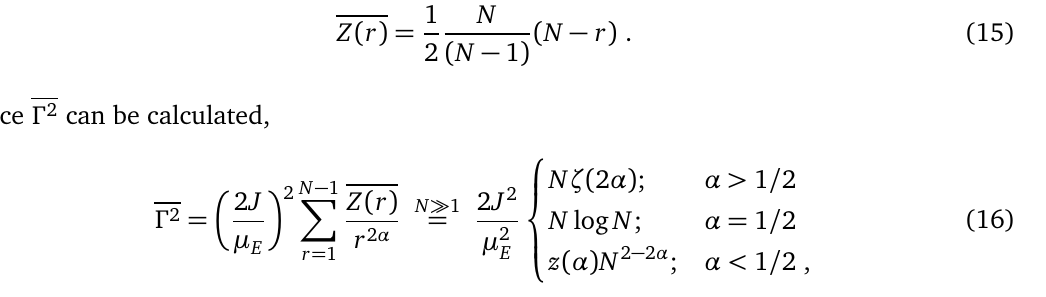
Figure 1: Distributions of Fock-space site energies: For β = 0.25 and 4, and for system sizes N = 8 − 16, the first two panels show the distributions P i.e. taken relative to their means and scaled with their standard deviations, µ red dashed line shows a standard Normal distribution, which clearly captures the numerics. The insets show the bare distributions, vs N on logarithmic axes for the same two values of β . The exponents for the polynomial growth in N , as shown by the dashed lines, corroborate the predictions of Eq. (26). = 1 = W Results are shown for J z